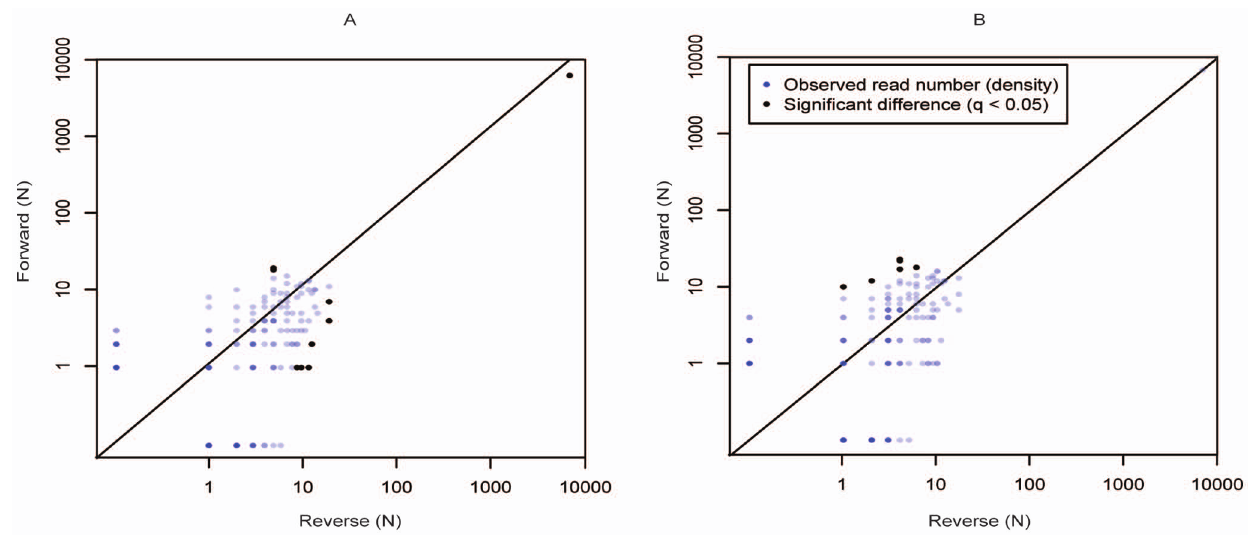
Figure 4. PCR/UDPS error ratio in our cleaned data. This figure shows a comparison of the counts of reverse to forward variants of run 1. A) Our filtered UDPS data. B) Same data, normalized by the main variant forward and reverse counts.